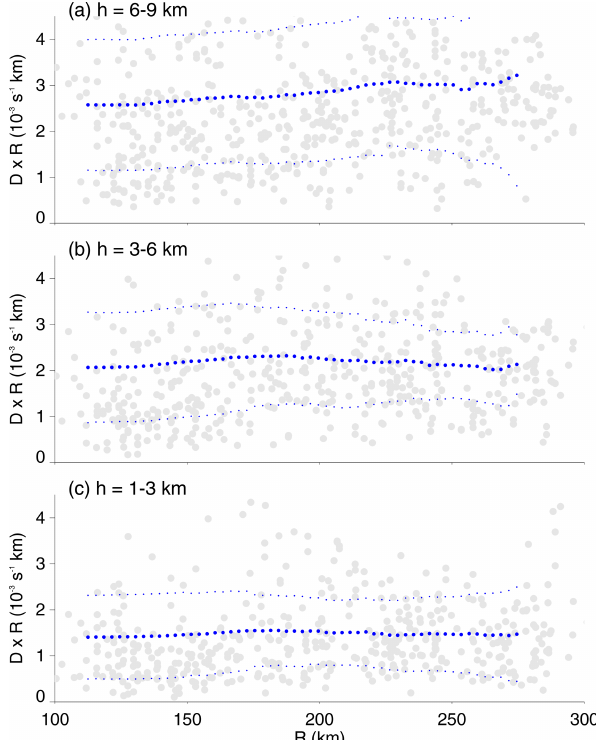
Figure 5. Divergence amplitude anomaly (defined as maximum mi- nus minimum at (a) 6–9km, (b) 3–6km, and (c) 1–3km altitude) multiplied by equivalent radius, as a function of equivalent radius. Based on divergence from 3D-Var applied to the sounding network. Thick (thin) blue dots show the running mean ( ± 1 standard devia- tion), using R intervals of